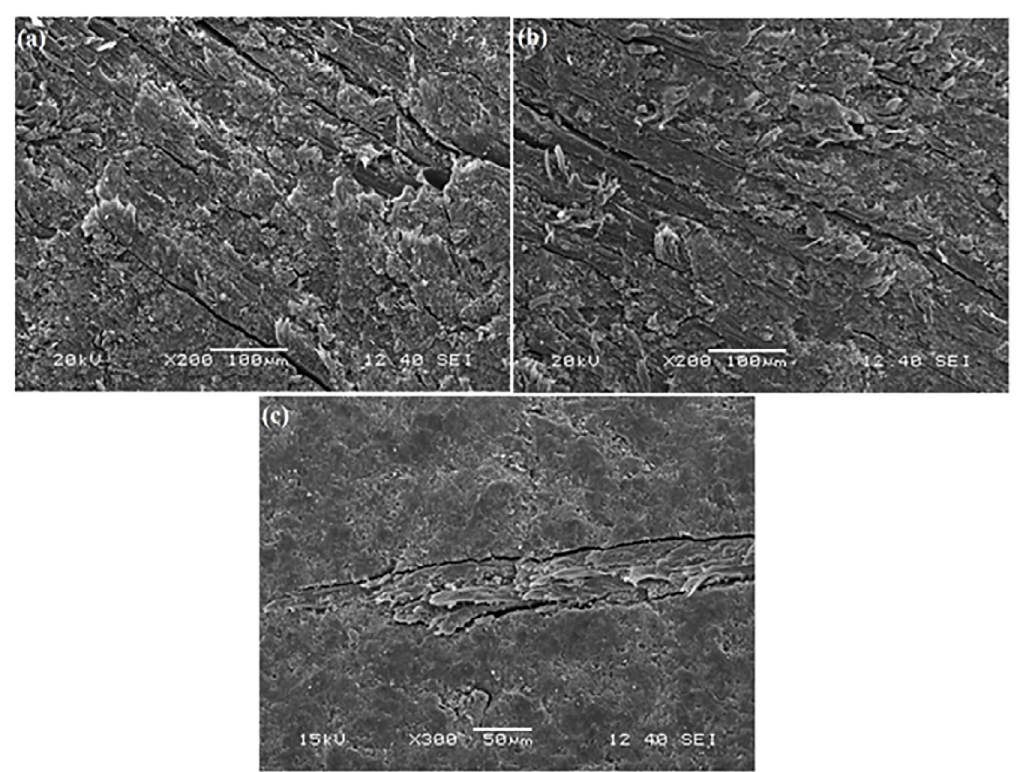
Figure 8. SEM images of (a) Untreated (b) Alkali treated and (c) Benzoyl chloride treated composite surfaces after three body abrasion at 30 wt.% of fiber loading subjected to Sliding distance of 80